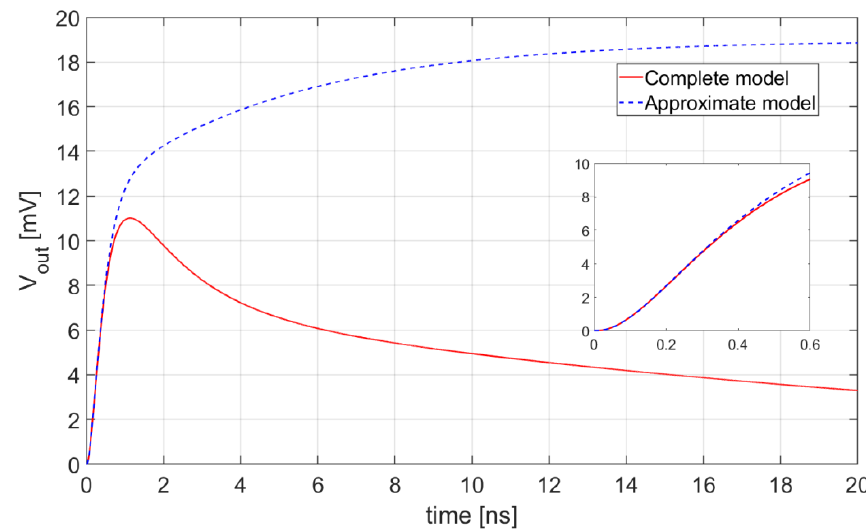
Figure 5. Comparison between the waveforms V out (t) obtained from Equations (9) (complete model) and (11) (approximate model). The inset shows the early part of the transient response.